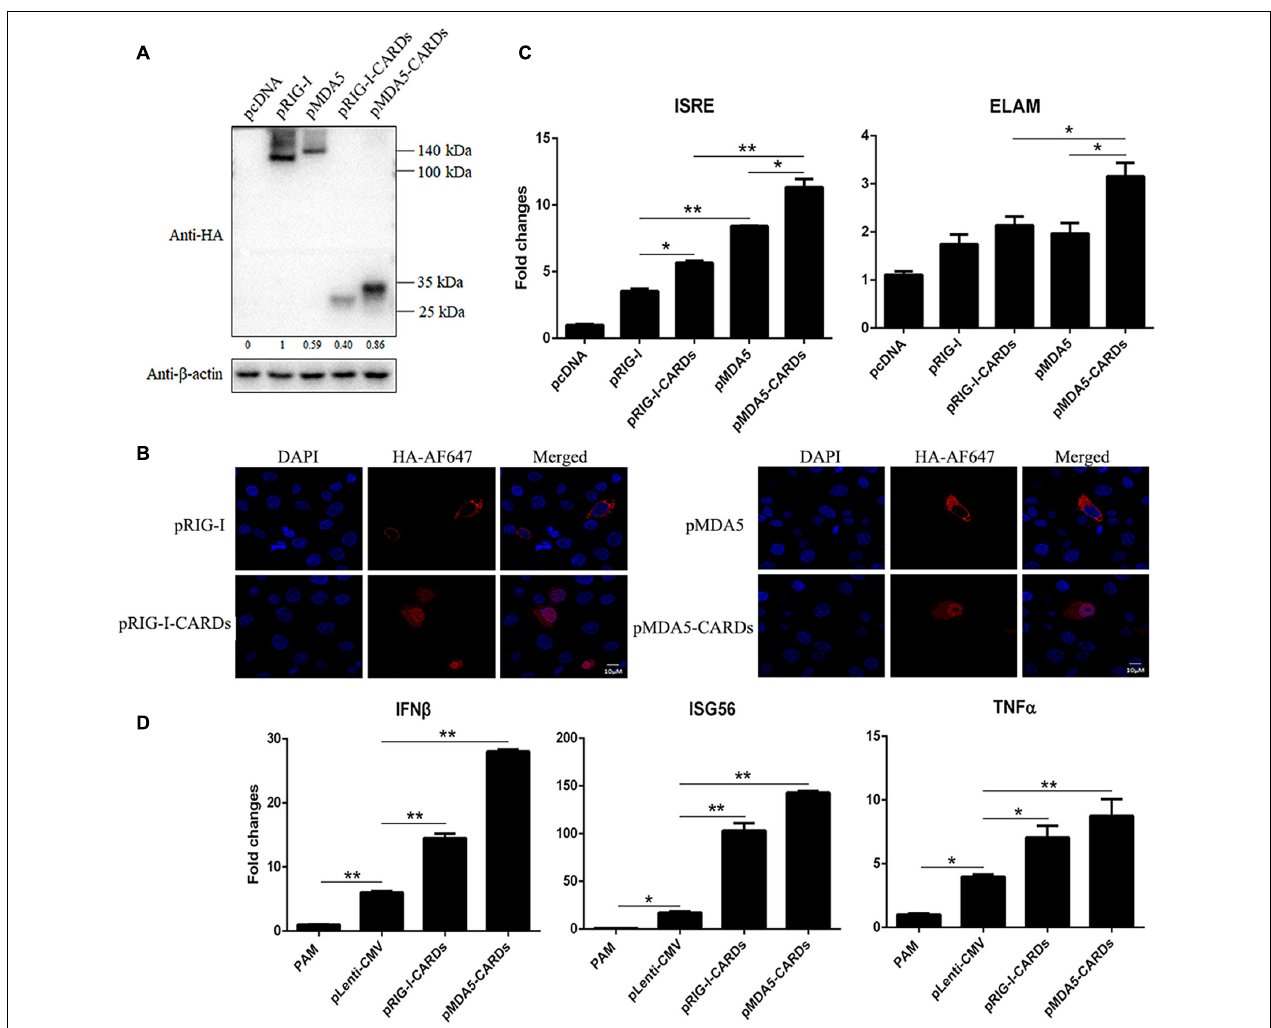
FIGURE 1 | The protein expression, cellular localization and signaling activity of porcine RIG-I and MDA5 CARDs. (A) The pRIG-I-HA, pMDA5-HA, pRIG-I-CARDs-HA, pMDA5-CARDs-HA, and vector pcDNA (0.5 µ g each) were transfected into 293T cells in 24-well plates (3 × 10 5 cells/well) for 24 h using Lipofectamine 2000 (Thermo Fisher Scientific). The cells samples were detected by Western-blotting with anti-HA and anti-actin mAb. The densitometry values after actin normalization were shown below the blot. (B) PAMs grown on 15-nm glass bottom cell culture dish (5 × 10 5 cells) were transfected with the indicated pcDNA expression plasmids (0.75 µ g each) using TransIT-LT1 Transfection Reagent for 24 h. The cells were examined for localization by con-focal fluorescence microscopy. (C) PAMs grown in 96-well plates (2 × 10 4 cells/well) were transfected with 20 ng indicated pcDNA expression plasmids, plus ISRE-Fluc/ELAM-Fluc (10 ng)